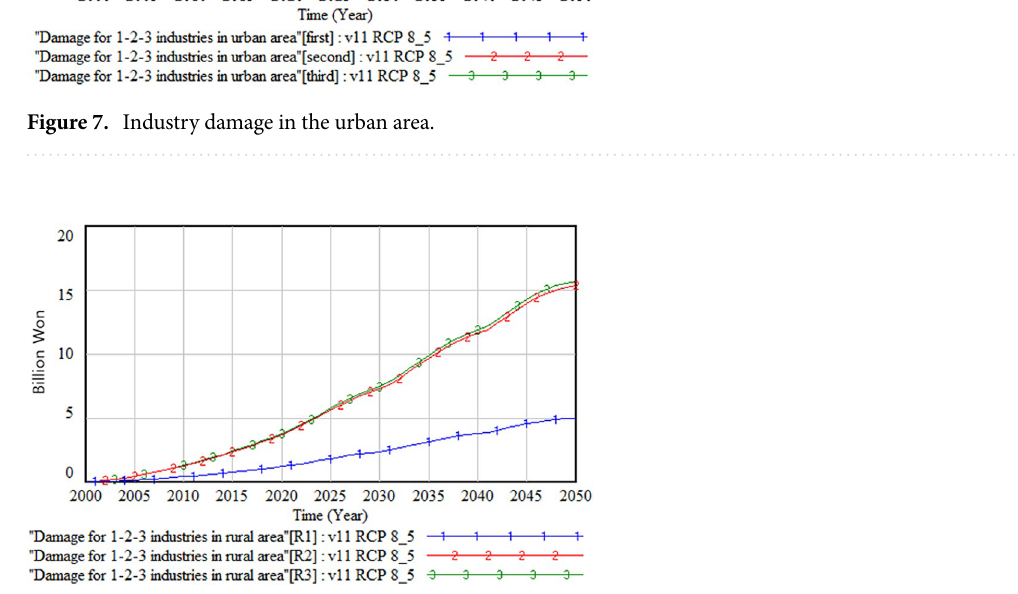
Figure 8. Industry damage in the rural